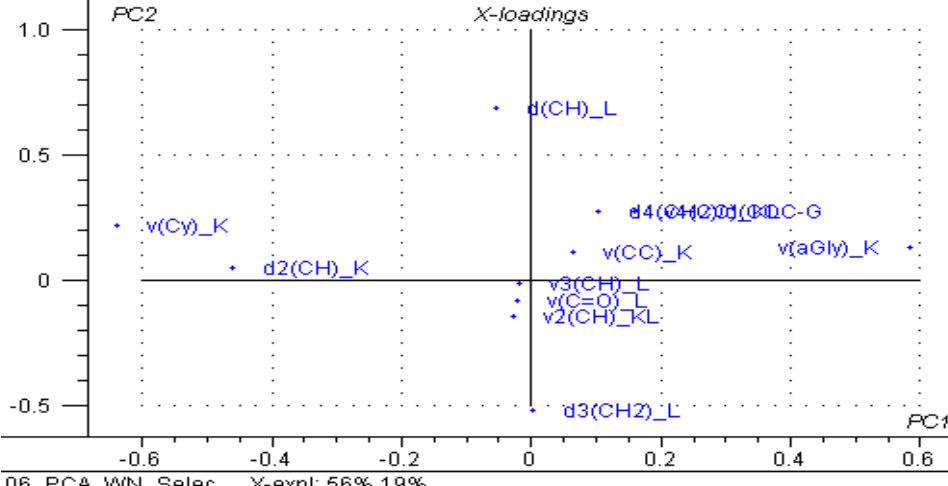
Figure 10. PC 2 versus PC 1 loadings plot from the PCA analysis of the selected FTIR band wavenumber data (see the text) of the β-cyclodextrin/unprocessed and processed chicken breast and thigh lipid complexes, β-cyclodextrin and non-complexed lipid fractions; variable codes contain “v” or “d” for the stretching and bending vibrations of the corresponding bonds (in parenthesis), followed by the source (“K” for β-cyclodextrin and “L” for lipids); e.g., “v(aGly)_K” stands for the variable corresponding to the wavenumber of the stretching vibration of the α (1 → 4) glucosidic bond from β-CD at ~859 cm −1 (for all variable codes, see Table S1 from the Supplementary Materials file).